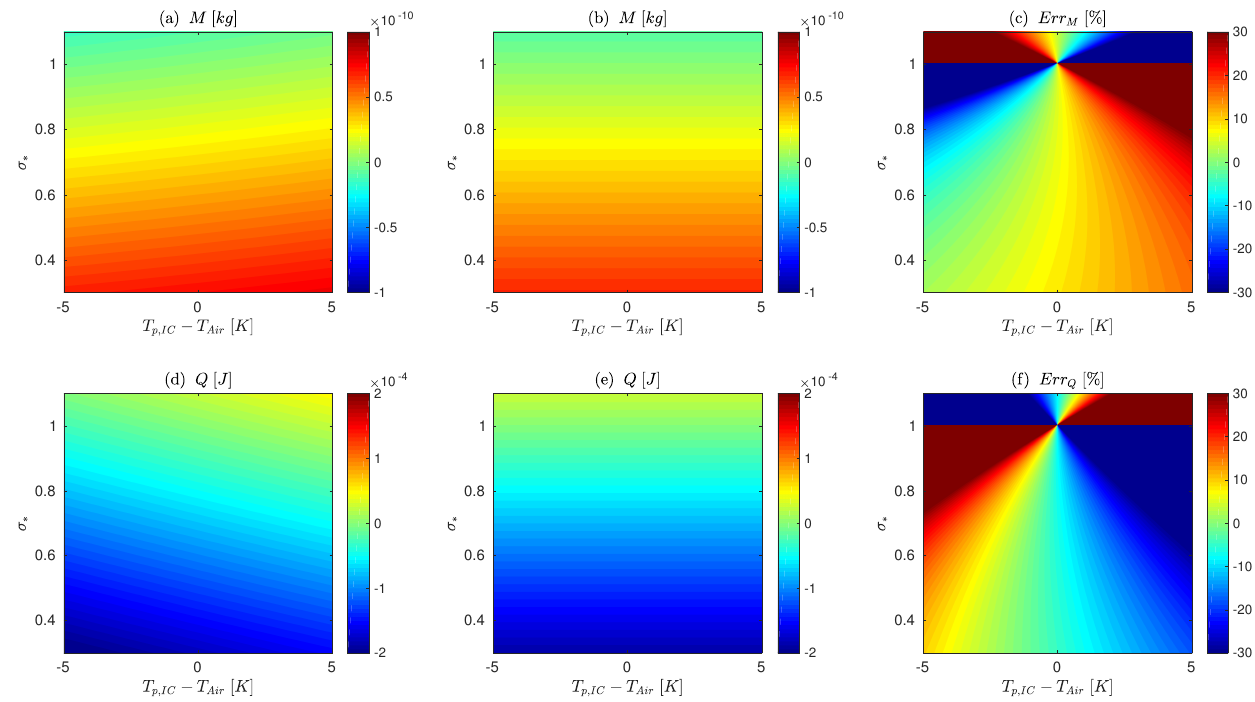
Figure 3. TM and NUM solutions for a particle of 200µm diameter in different environmental conditions. Experiment II: total mass output during 0.5s by the (a) NUM and (b) TM solutions with (c) corresponding error for (cid:8) 0 . 3 (cid:54) σ ∗ (cid:54) 1 . 1 , − 5K (cid:54) T p − T Air (cid:54) 5K (cid:9) . Similar plots for total heat output presented in (d) – (f)